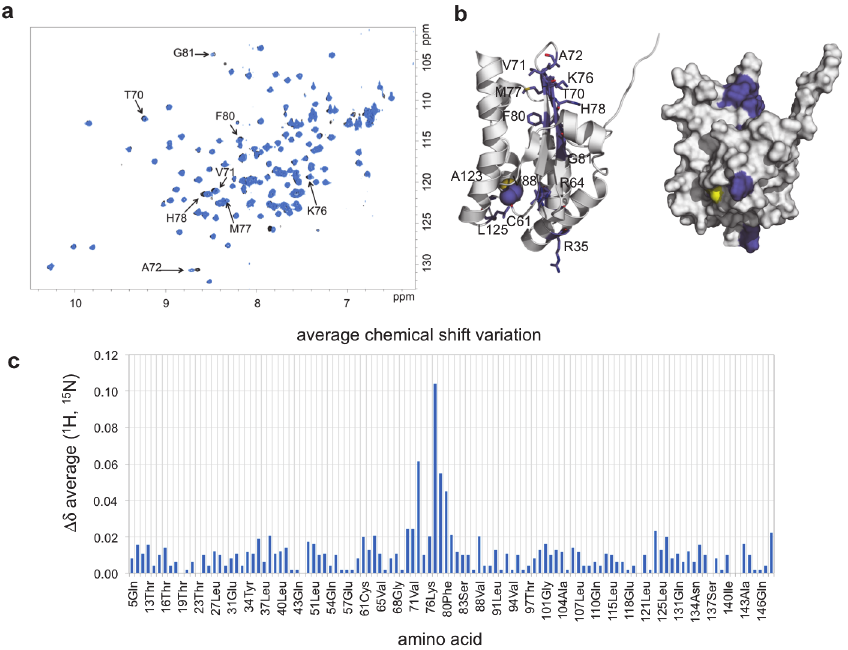
Fig 6. TcdA interacts transiently with the sulfur-acceptor SufE-like protein CsdE. a NMR 1 H- 15 N NOESY spectrum of doubly labeled 13 C, 15 N-CsdE in presence (blue) or absence (black) of unlabeled TcdA. Significant shifts in the position of specific NOESY resonance peaks for CsdE residues are labeled. b The position of the affected amino acid residues is mapped onto the NMR structure of CsdE (PDB 1NI7) in ribbon (left) and surface (right) representations. c Average chemical shift ( Δδ ) of 13 C, 15 N-CsdE upon binding to TcdA as measured from the NOESY spectrum in a plotted against the CsdE amino acid sequence.